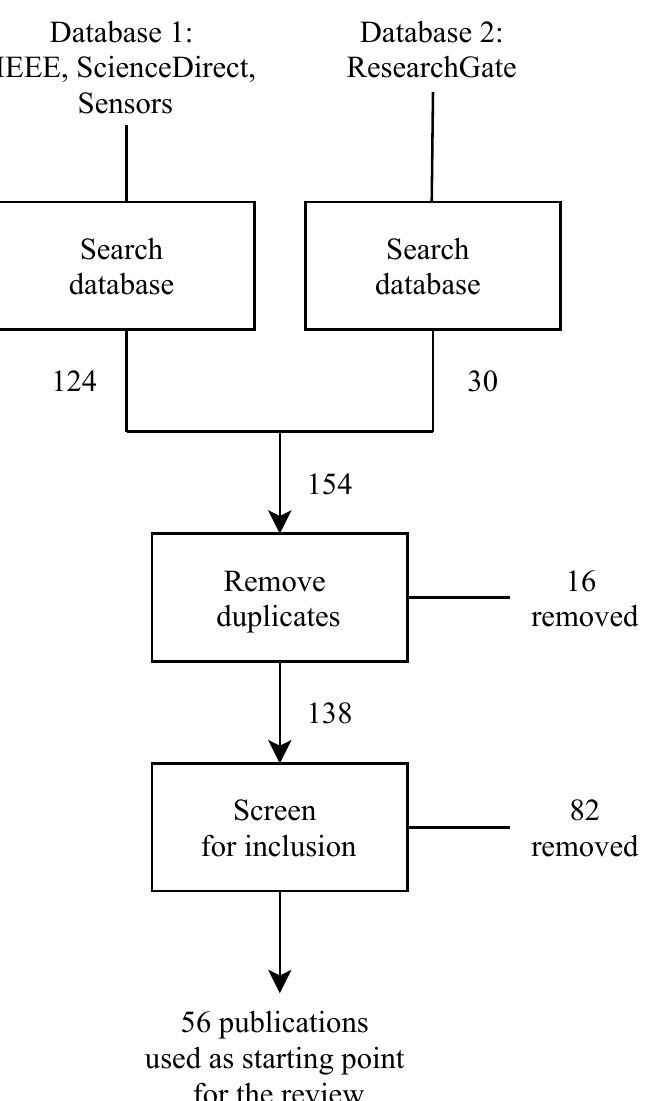
Figure 1. The flow diagram (1) illustrates the strategy used for our survey of the literature on driver monitoring (DM) and driver-monitoring systems (DMSs), and (2) shows the number of publications at each stage of the